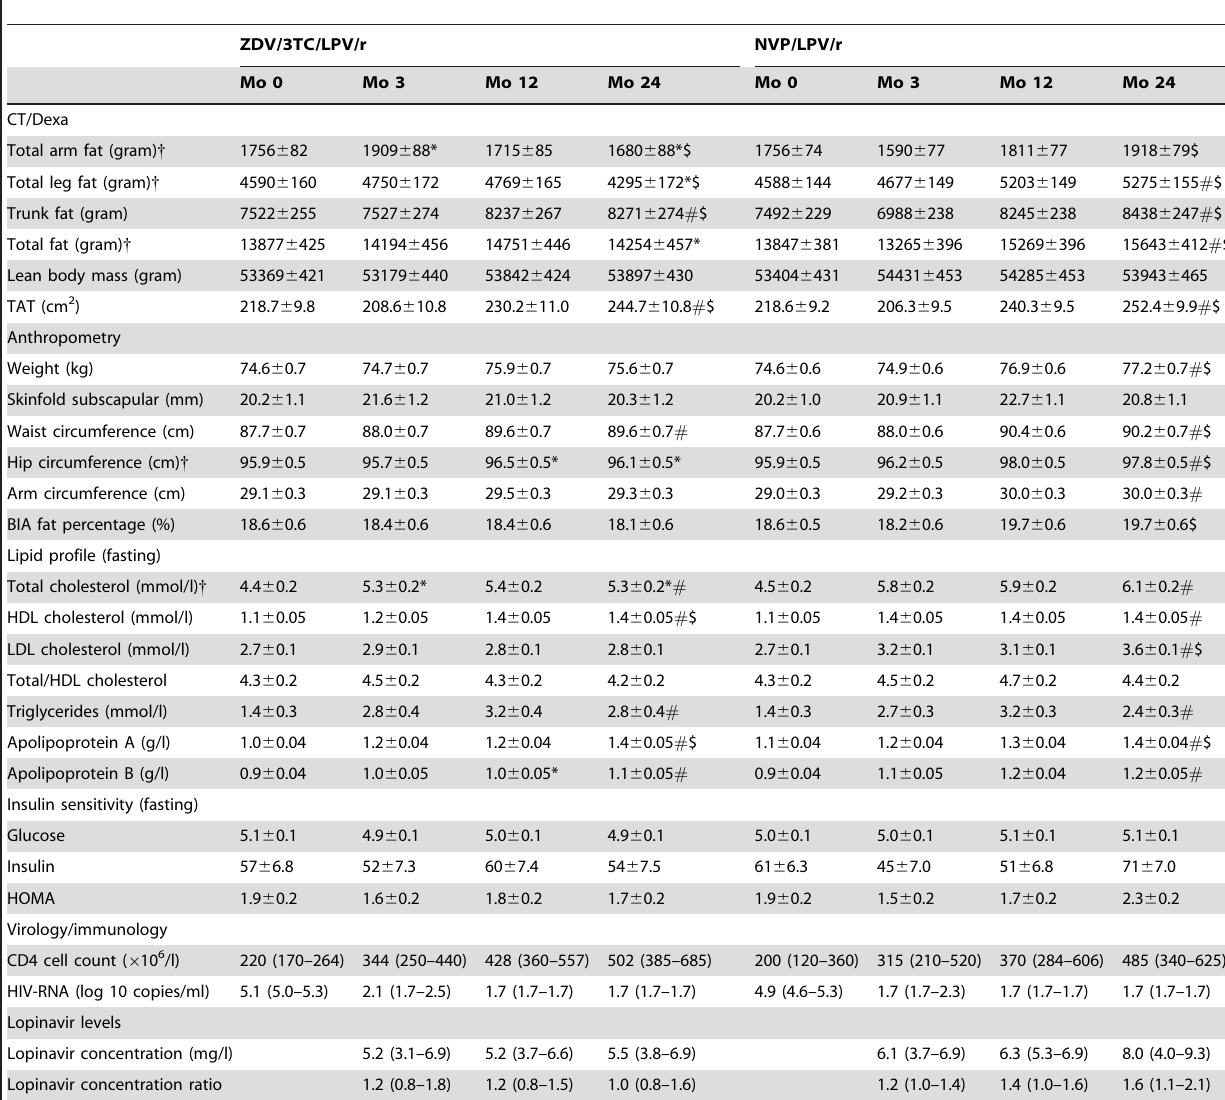
Table 2. Body composition, lipid profile, insulin sensitivity, virology/immunology and lopinavir